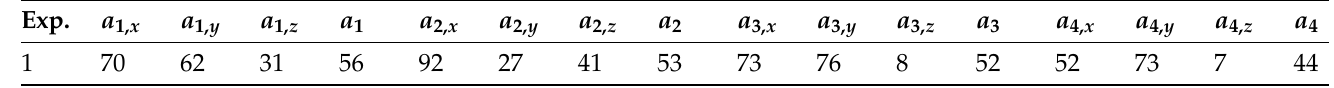
Table 9. ET amplitude reduction rates during the Prototype (B) Open-Loop evaluation. Exp.